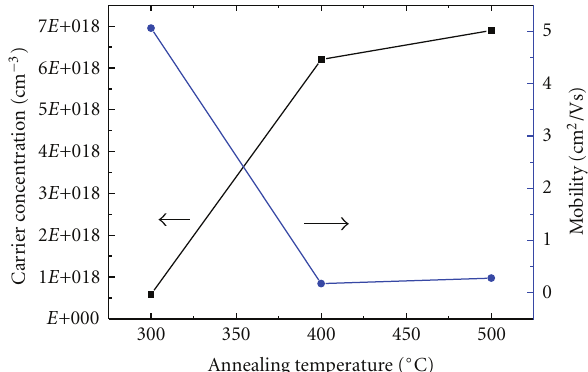
Figure 4: The carrier concentration and the mobility as a function of thermal oxidation annealing